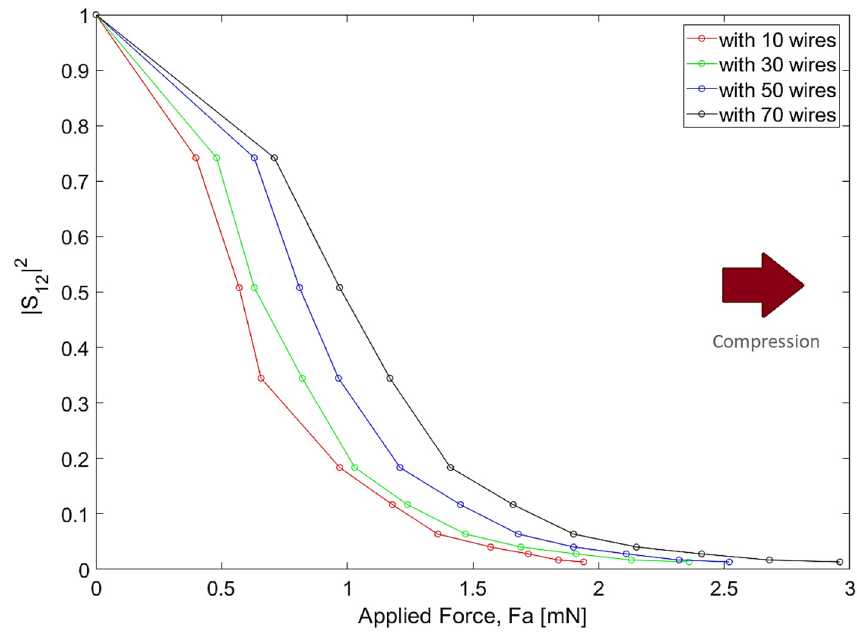
Figure 15. Reflectance as a function of applied force for 10, 30, 50 and 70 wires and a filter assembled with PTFE.